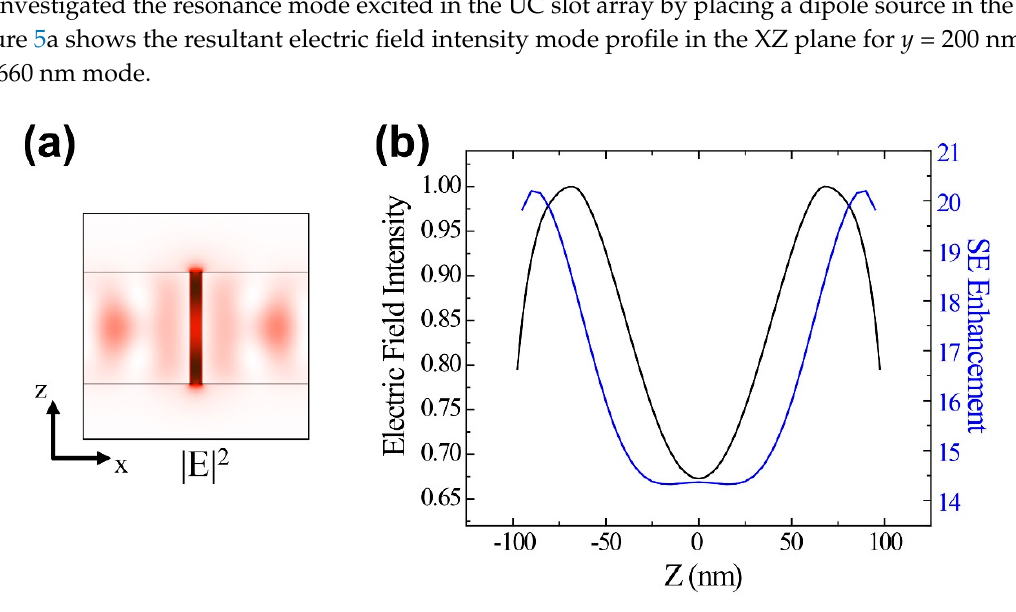
Table 1. Incident light (970 nm) absorption and spontaneous emission (SE, 660 nm) enhancement for the proposed upconversion (UC) slot array and 40-mm-thick reference UC film.